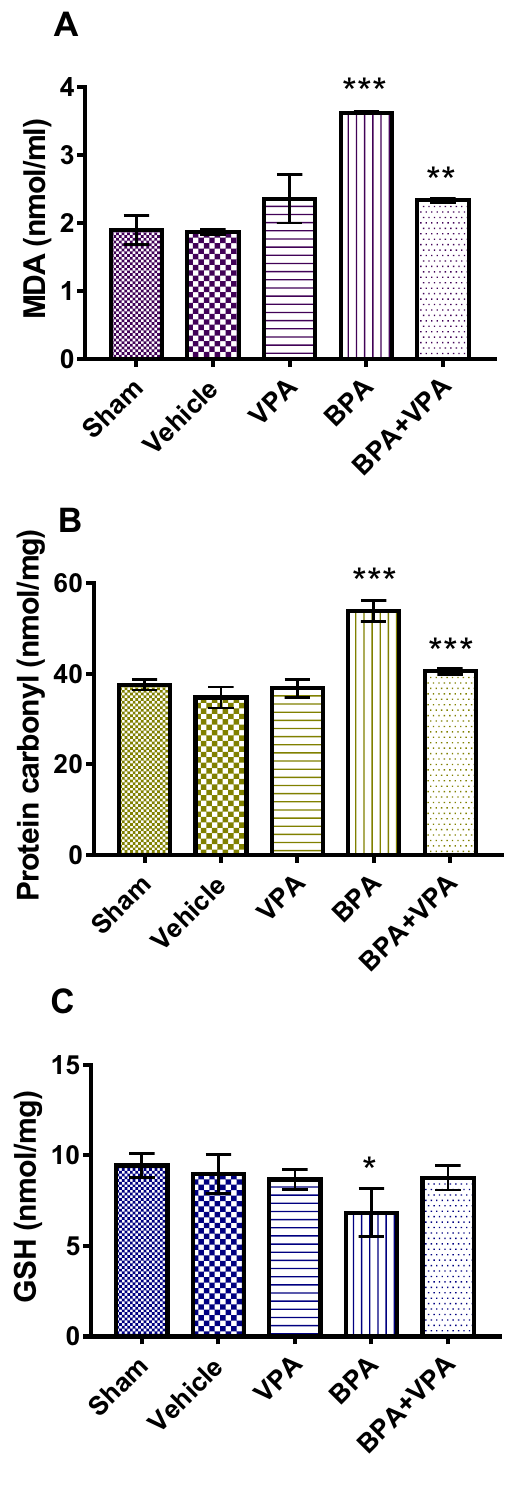
Figure 5. VPA decreased oxidative stress markers MDA and PC and enhanced the antioxidant marker GSH in BPA-exposed mice. ( A ) Measurement of MDA levels (nmol/mL). ( B ) Measurement of PC content (nmol/ mg). ( C ) Measurement of reduced GSH (nmol/mg). Data are represented as the mean ± SEM ( n = 6 per group). * P < 0.05, ** P < 0.01, and *** P < 0.001. VPA valproic acid, BPA bisphenol A, MDA malondialdehyde, PC protein carbonyl, GSH glutathione, SEM standard error of the